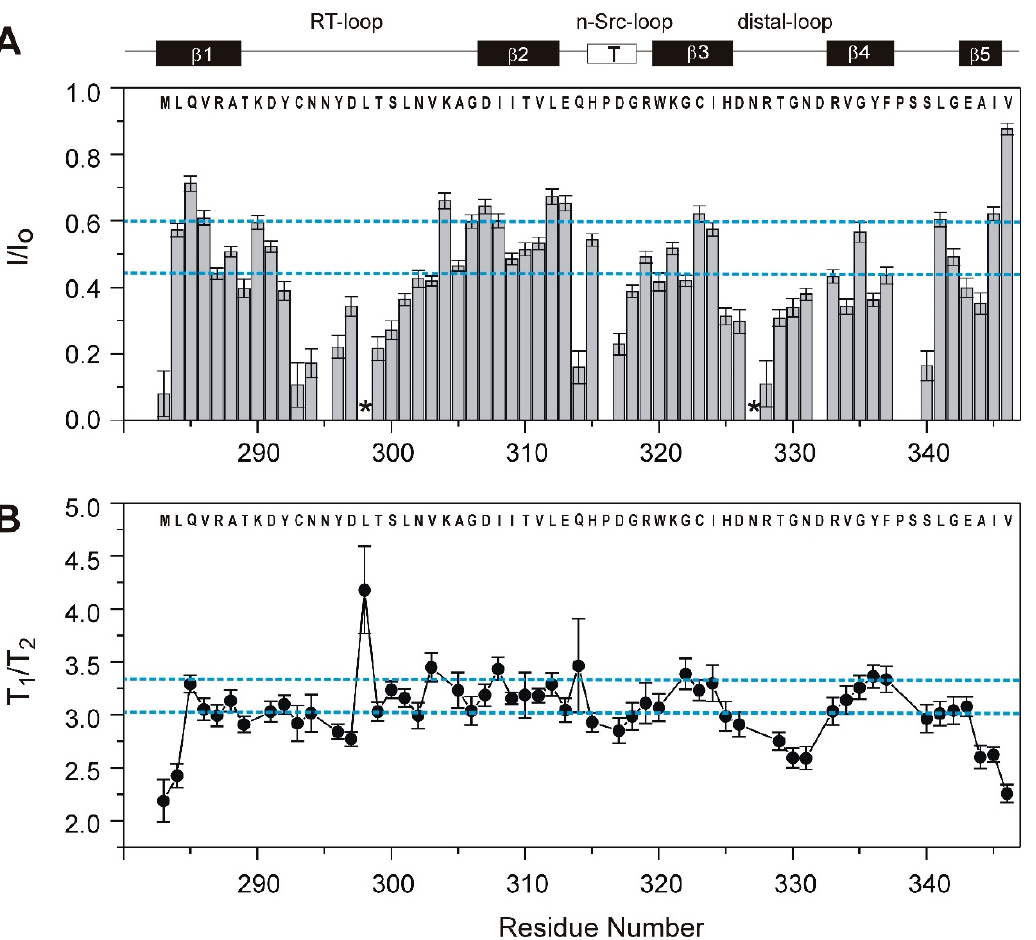
Figure 4. Summary of NMR parameters diagnostic of slow motions and local unfolding events in the SH3 domain of human Caskin1. ( A ) Ratio of relative peak intensities with (I) and without (I o ) presaturation of the solvent resonance and ( B ) ratio of the longitudinal (T 1 ) and transverse (T 2 ) relaxation times as a function of the amino acid sequence. Error bars are shown. Dashed lines correspond to the mean and the mean plus one standard deviation. At residues marked with an asterisk in ( A ) fast solvent exchange obscures the analysis. Secondary structural elements are indicated at the top. Longitudinal and transverse relaxation times averaged around T 1 = 449 ± 42 ms and T 2 = 149 ± 23 ms, respectively, matching the values expected for an ~70-residue globular protein at the investigated temperature (20 °C).